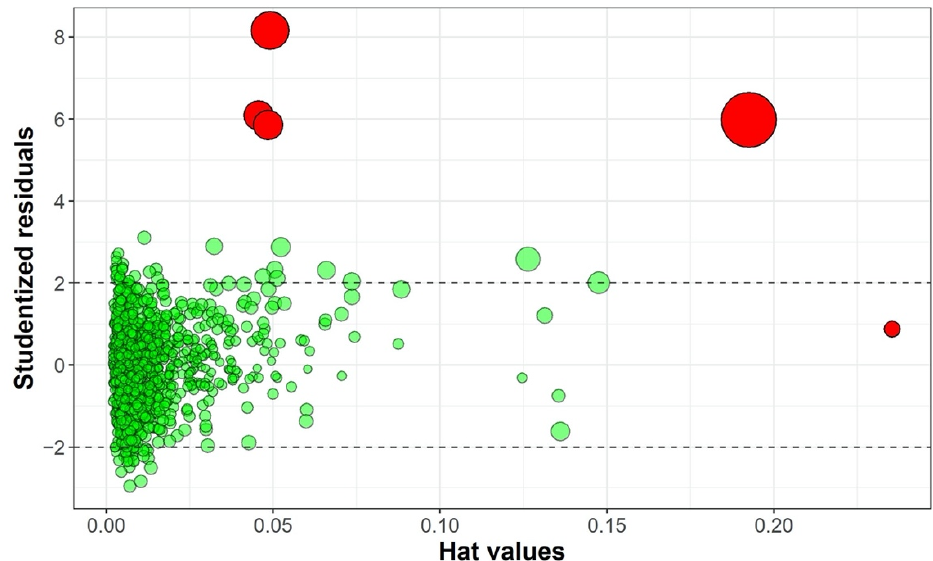
Figure 4. Hat values vs. studentized residuals (green dots are normal range observations and red dots are outliers).